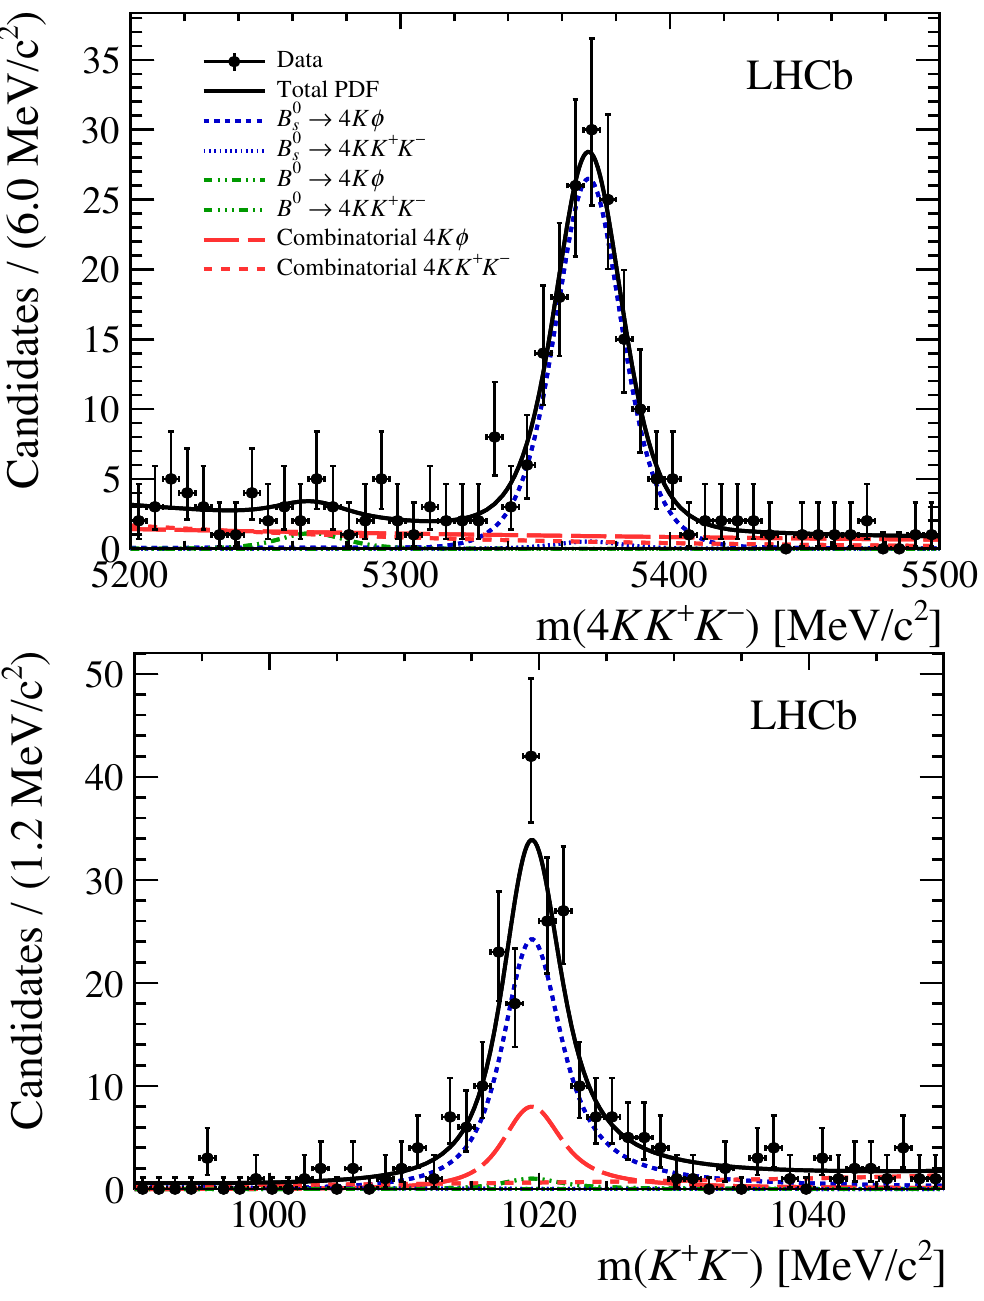
Figure 9 . Distribution of the 4 KK + K (cid:0) (top) and K + K (cid:0) (bottom) invariant masses. Points with error bars show the data. The solid black curve is the projection of the total (cid:12)t result. The ! 4 KK + K (cid:0) contributions, short-dashed and dotted blue curves show the B 0 ! 4 K(cid:30) and B 0 s s respectively. The long-dashed and medium-dashed red curves show the contributions of the com- binatorial background with prompt (cid:30) and NR K + K (cid:0) , respectively. The dashed-double-dotted and dashed-triple-dotted green curves show the B 0 ! 4 K(cid:30) and B 0 ! 4 KK + K (cid:0) contributions, respectively.